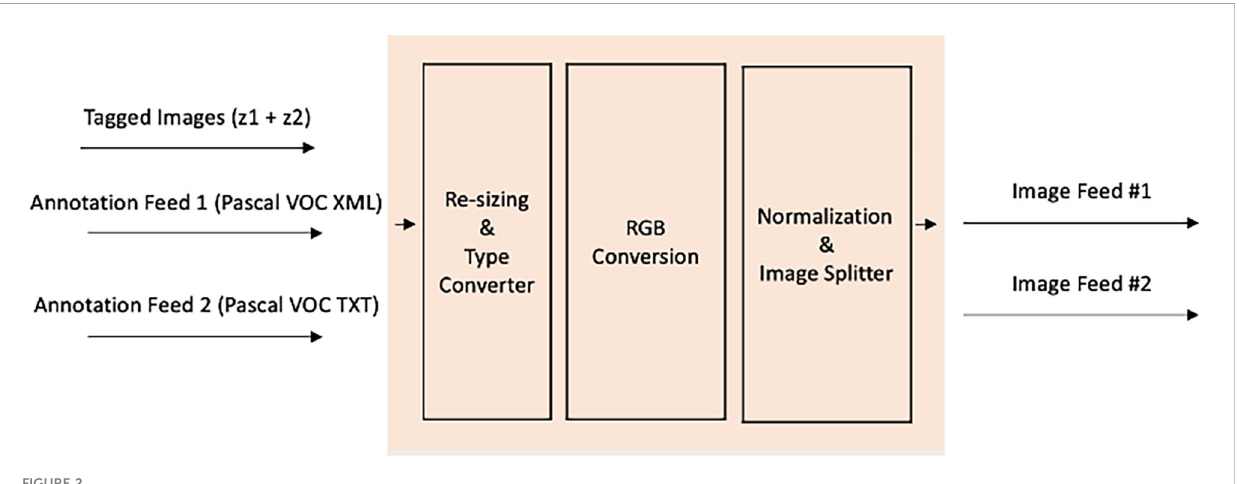
FIGURE 2 Image Processing